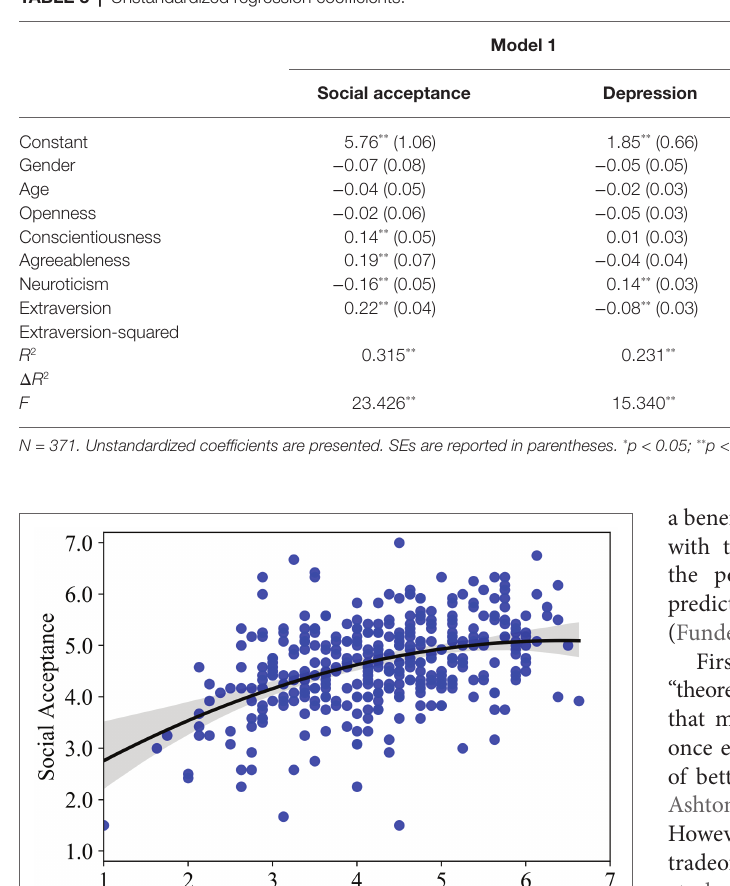
TABLE 3 | Unstandardized regression coefficients.